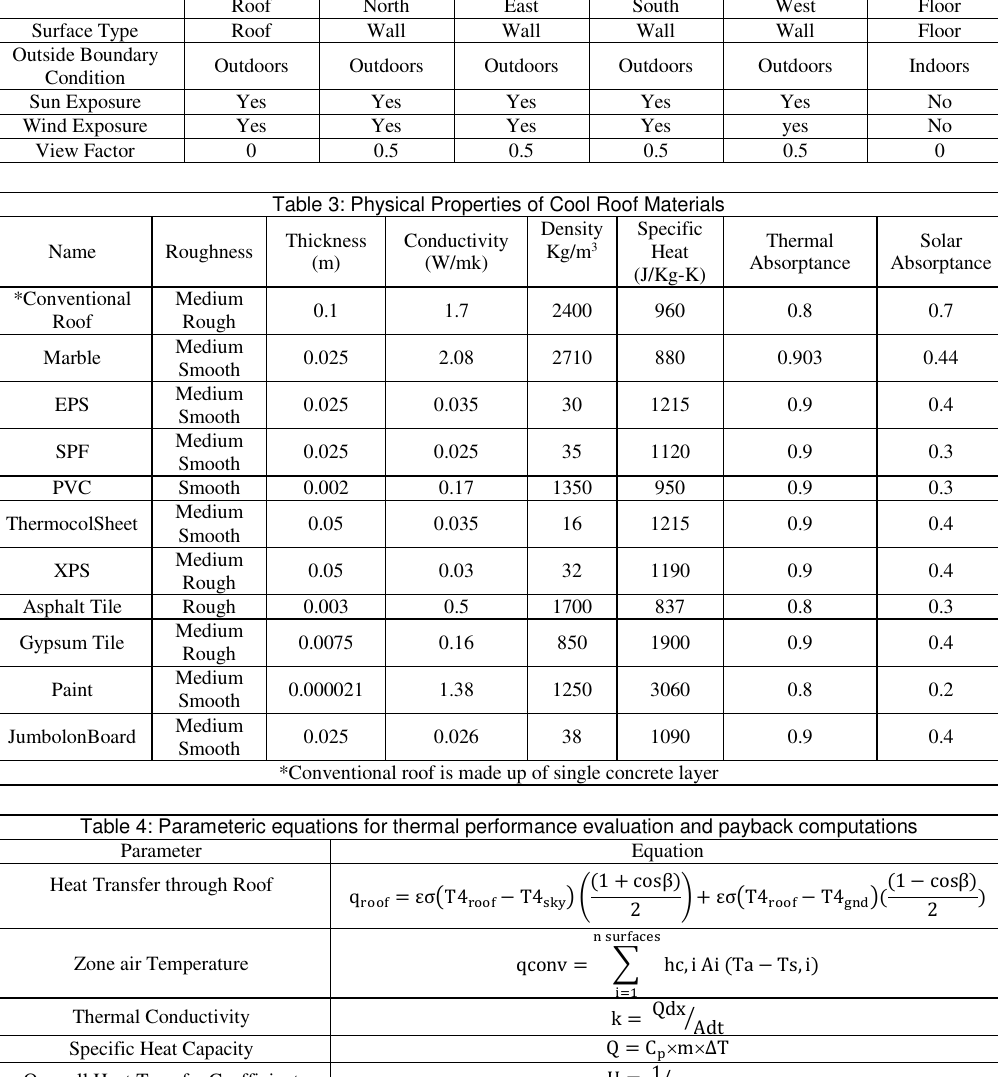
Table 2: Boundary Conditions for Selected Building Roof